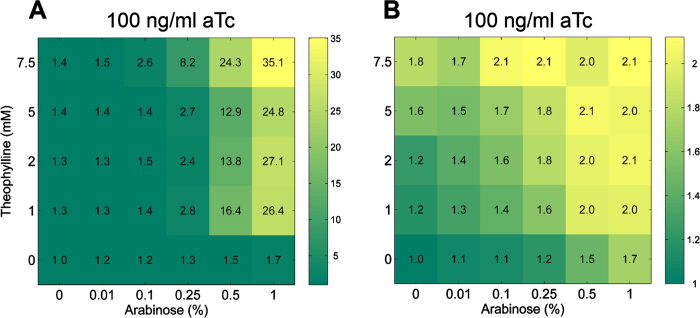
Repression trajectories of PTet based target modules.(A) Response of the pRibo1TALE1/pTetTBS1 repression system as a function of arabinose and theophylline concentrations at saturating levels of aTc (100 ng/ml), (B) Response of the pRibo1TALE2/pTetTBS2 repression system as a function of arabinose and theophylline concentrations at saturating levels of aTc (100 ng/ml). Color bar indicates fold repression. KD of TALE1, 240 ± 40 nM; KD of TALE2, 1.3 ± 0.3 nM.